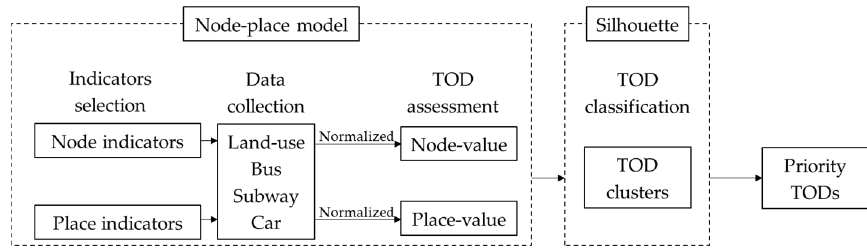
Figure 2. The research flow chart.